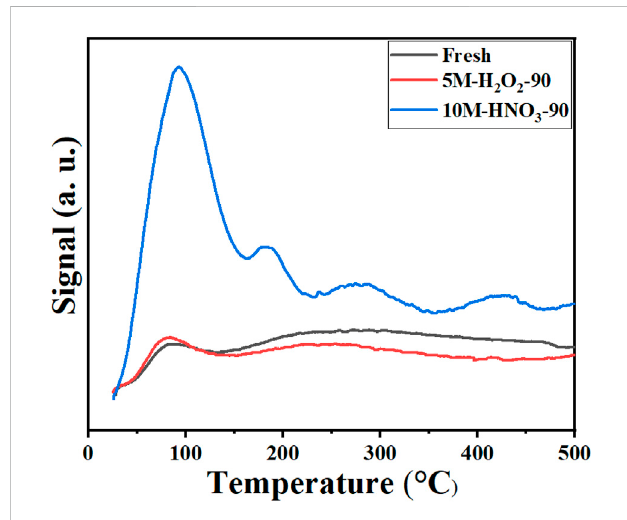
FIGURE 8 NH 3 -TPD pro fi les of the typical activated carbon samples.